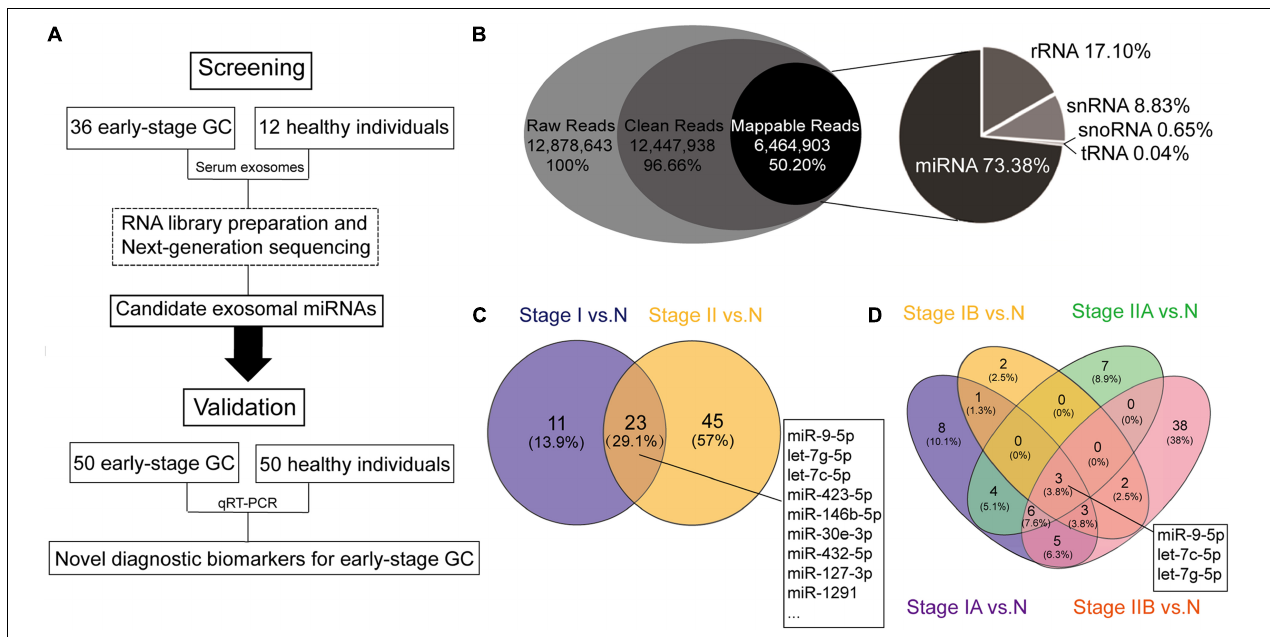
FIGURE 1 | Schematic flowchart of the analytical pipeline and the results based on the next-generation sequencing (NGS). (A) Schematic flowchart of identification of early-stage gastric cancer (GC)-specific exosomal miRNAs. (B) RNA biotypes in the small RNA library prepared from human serum exosomes. Pie chart showing the mean percentage reads of serum exosomal small RNA library. Raw reads were the sequences obtained by RNA sequencing (RNA-seq). Clean reads were generated after read filtering and adapter trimming. Mappable reads were the RNA-seq reads mapped to known human RNAs, and were sorted into the following small ncRNAs: micro RNA (miRNA), ribosomal RNA (rRNA), small nuclear RNA (snRNA), small nucleolar RNA (snoRNA), and transfer RNA (tRNA). (C) Venn diagram showing overlap of the differentially expressed miRNAs between stage I gastric cancer vs. healthy individuals (stage I vs. N) and stage II gastric cancer vs. healthy individuals (stage II vs. N). (D) Venn diagram showing overlap of the differentially expressed miRNAs in all four stages (stages IA, IB, IIA, and IIB) vs. healthy individuals